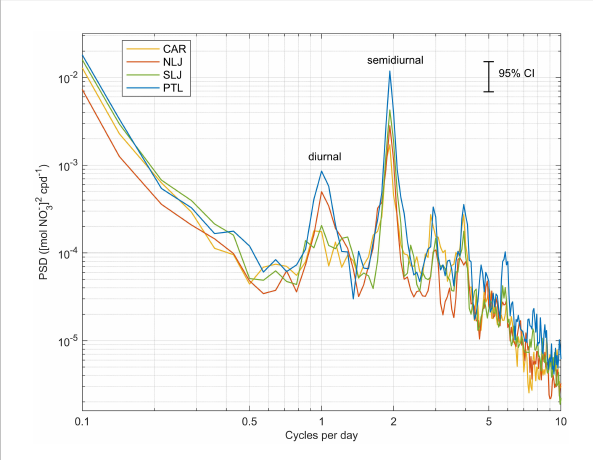
FIGURE 6 Power spectral density of water column integrated NO 3- at each kelp forest study site for the study period Jun 2014 through May 2015. Error bar shows 95% con fi dence interval for the spectra calculated on a series of 14-d windows with 50% overlap. Sites indicated by color shown in legend in upper